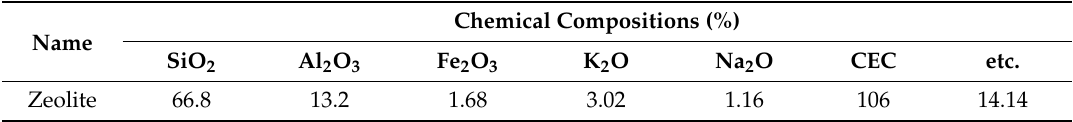
Table 3. Chemical compositions of natural zeolite.